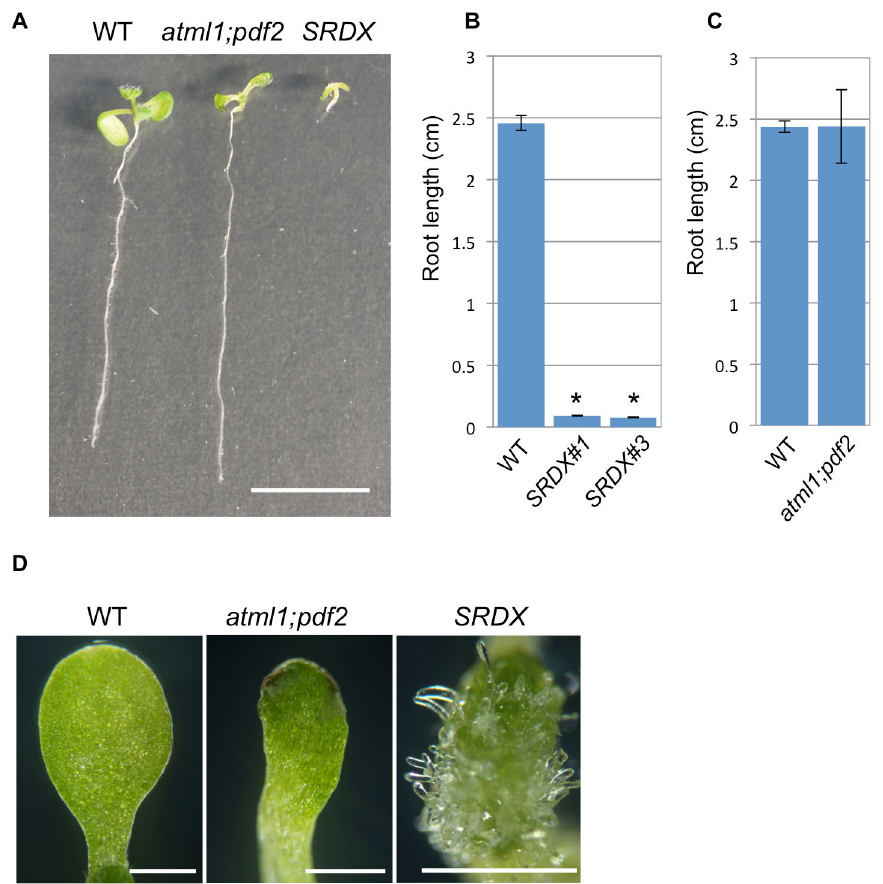
Figure 3. Phenotypes of strong ATML1-SRDX lines compared with those of atml1-1 ; pdf2-1 . ( A ) Seven-day-old seedlings of the wild-type Columbia (WT), atml1-1;pdf2-1 (atml1;pdf2), and a type I ATML1-SRDX line (SRDX) grown with 10 μM estradiol. ( B , C ) Quantification of the root length of seven-day-old type I ATML1-SRDX line ( SRDX#1 and SRDX#3 ; B) and atml1-1;pdf2-1 ( atml1;pdf2 ; C) seedlings grown with 10 μM estradiol. Values are the means ± SEM (n = 7–30). Asterisks indicate a statistically significant difference relative to the wild type grown under the same conditions (unpaired two-tailed t -test; p < 0.05). Columbia was used as the wild type in C. ( D ) Comparison of the cotyledon morphology of the wild type (WT), atml1-1;pdf2-1 (atml1;pdf2), and a type I ATML1-SRDX line (SRDX) grown with 10 μM estradiol for 7–8 days. Scale bars, 1 cm for A and 1 mm for